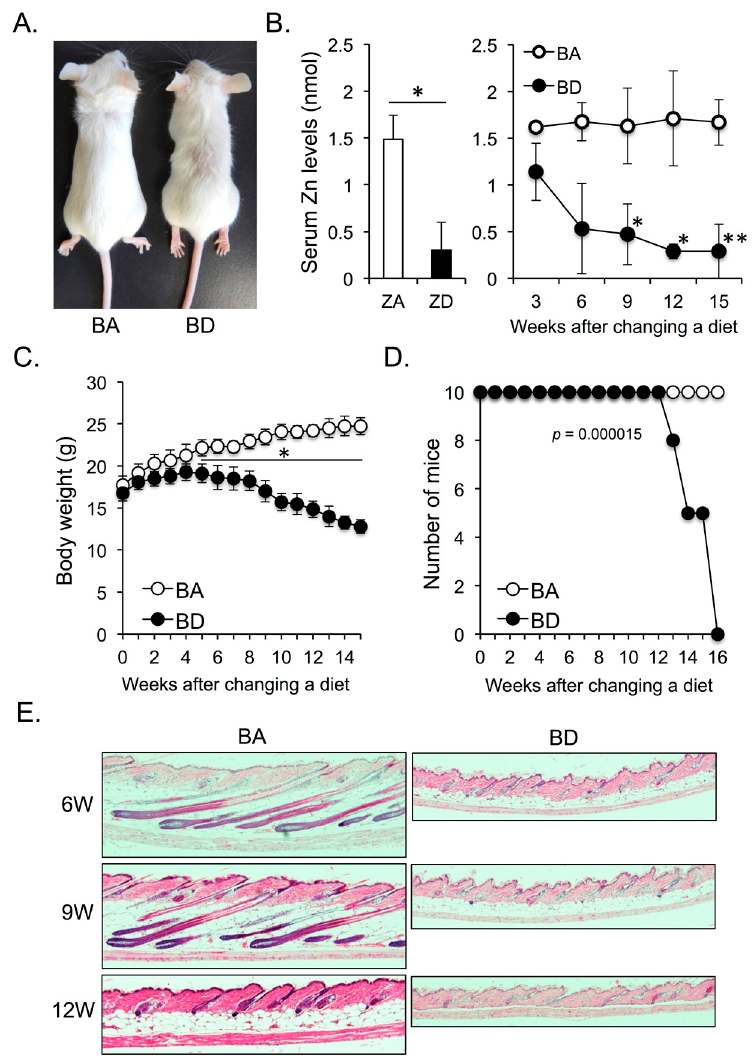
Figure 1. (A) Five-week-old female BALB/c mice were fed biotin-adequate (BA) (control diet) or biotin-deficient (BD) diet for 12 weeks. (B) Serum zinc levels of zinc-adequate (ZA) and zinc-deficient (ZD) mice after consumption of ZA (control) and ZD diet for seven weeks (left panel). Serum zinc levels of BA and BD mice fed BA (control) and BD diets for the indicated weeks (right panel). Five mice of each group were analyzed. Course of body weight (C) and survival rate (D) of BA and BD mice. Ten mice of each group were analyzed. (E) Change of skin phenotype of BA and BD mice after consumption of BA and BD diets for the indicated weeks (hematoxylin and eosin stain, × 100). Data are representative of three independent experiments. * p < 0.05, ** p < 0.01.